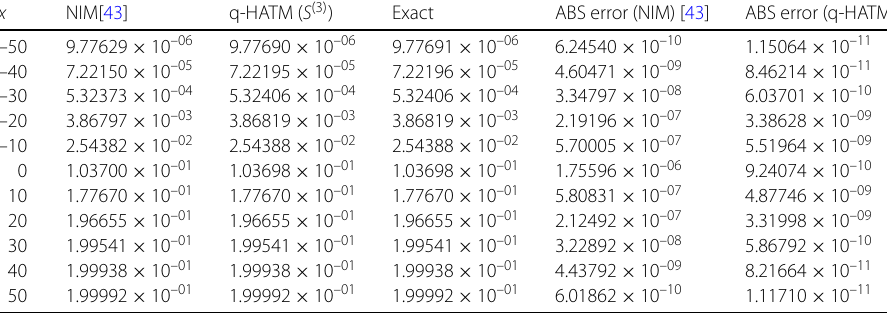
Table 10 The comparison of numerical result of S ( x , t ) obtained by NIM [43], q-HATM, and the exact solution Equation (35), also the absolute (ABS) errors when α = 1, (cid:2) = –1, k = r = λ = 0.1, and n = 1 for Example